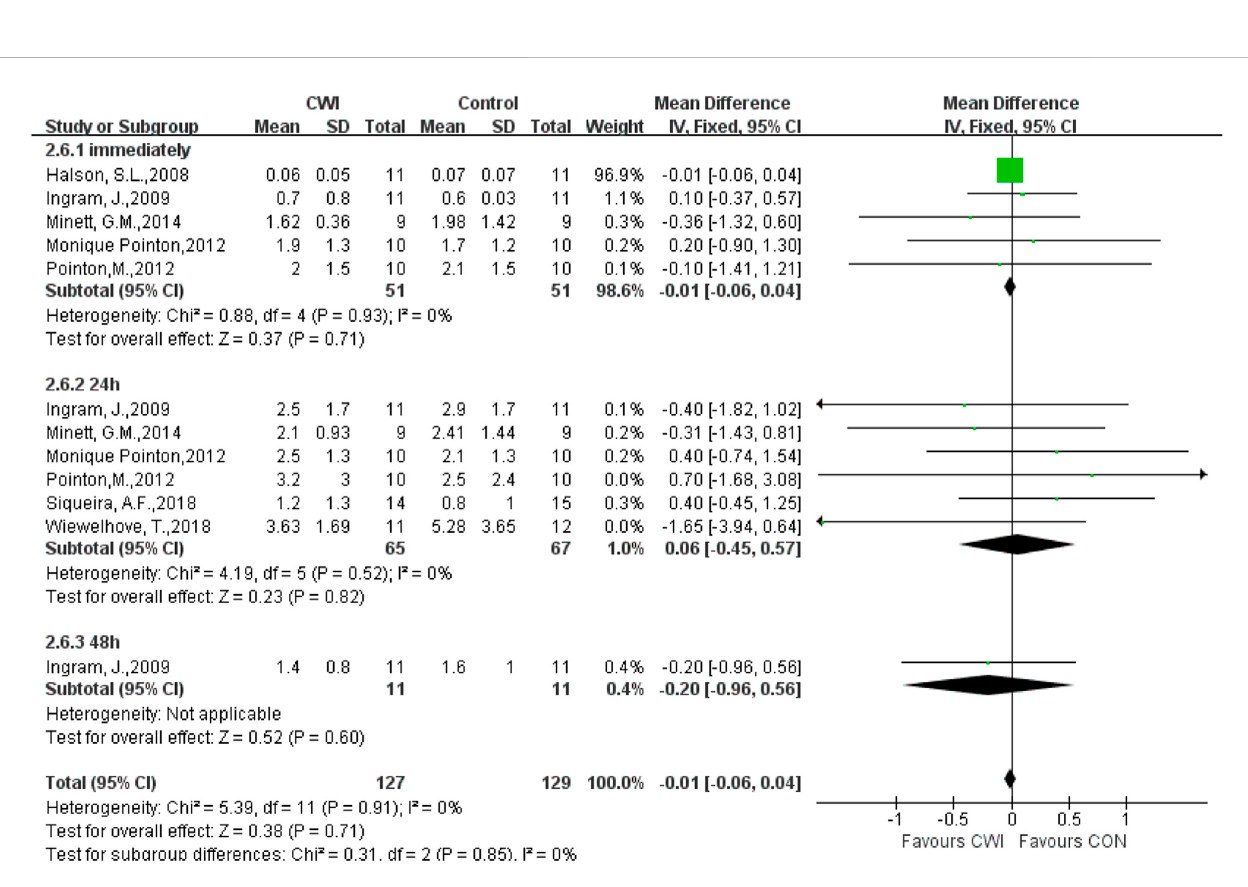
FIGURE 9 Forest plot of the comparison of CWI versus CON for measurement of CRP. CWI = Cold water immersion, CON = Control, CRP = C-Reactive Protein.